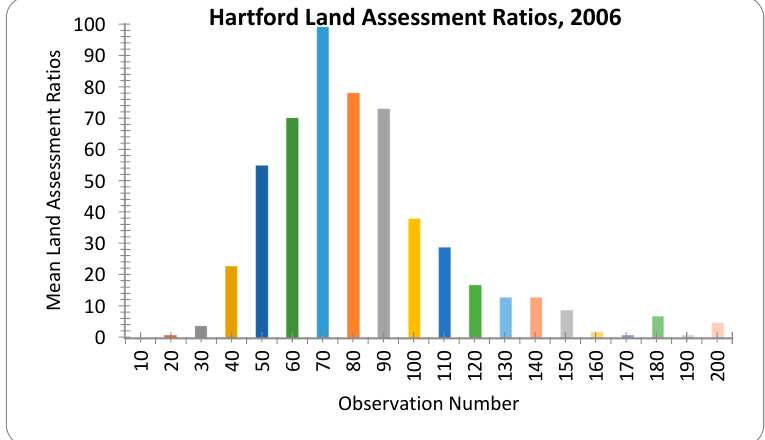
Figure 8. Hartford Land assessment ratios for the tax year 2006. The observation number (horizontal axis) is a range, and the Mean Land assessment ratio (vertical axis) is the mean overall ratio in the corresponding range. For instance, 10 indicates observations 0 to 10; 20 indicates observations 11 to 20; …; 200 indicates observations 200 and over.